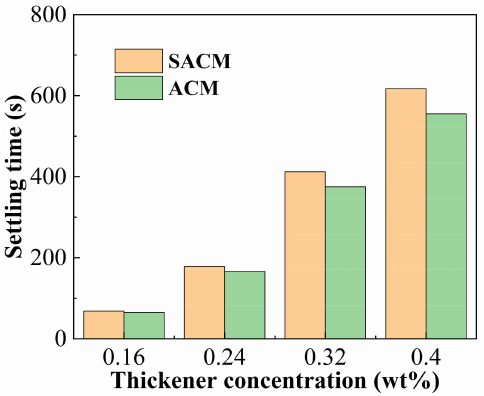
Figure 8. Sand-setting time of suspension diluent and powder